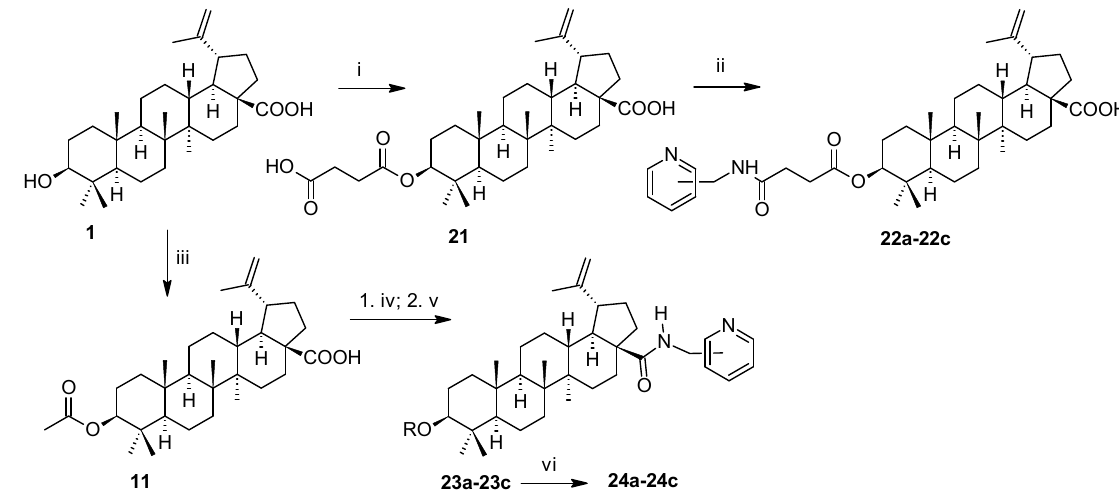
Scheme 4. Synthesis of picolyl amides of betulinic acid ( 1 ). Legend: i : succinic anhydride, DMAP, pyridine, ii : 2-, 3- or 4-aminomethylpyridine, T3P, dry pyridine, iii : Ac 2 O, EDIPA, DMAP, THF, iv : Table 2. Experimental cytotoxicity data found for 22a – 22c and 24a – 24c after 72 h.